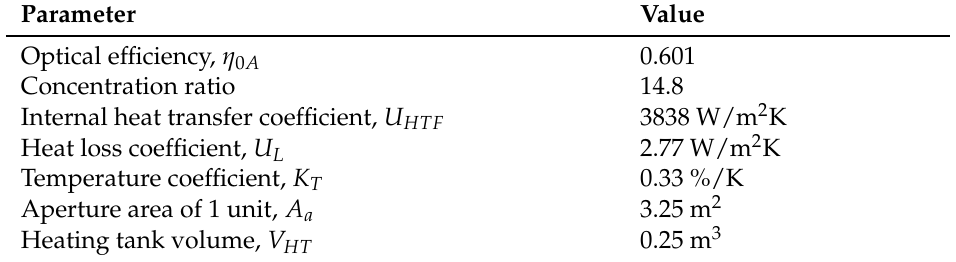
Table 1. Inputs for CPVT model in the TRNSYS simulation